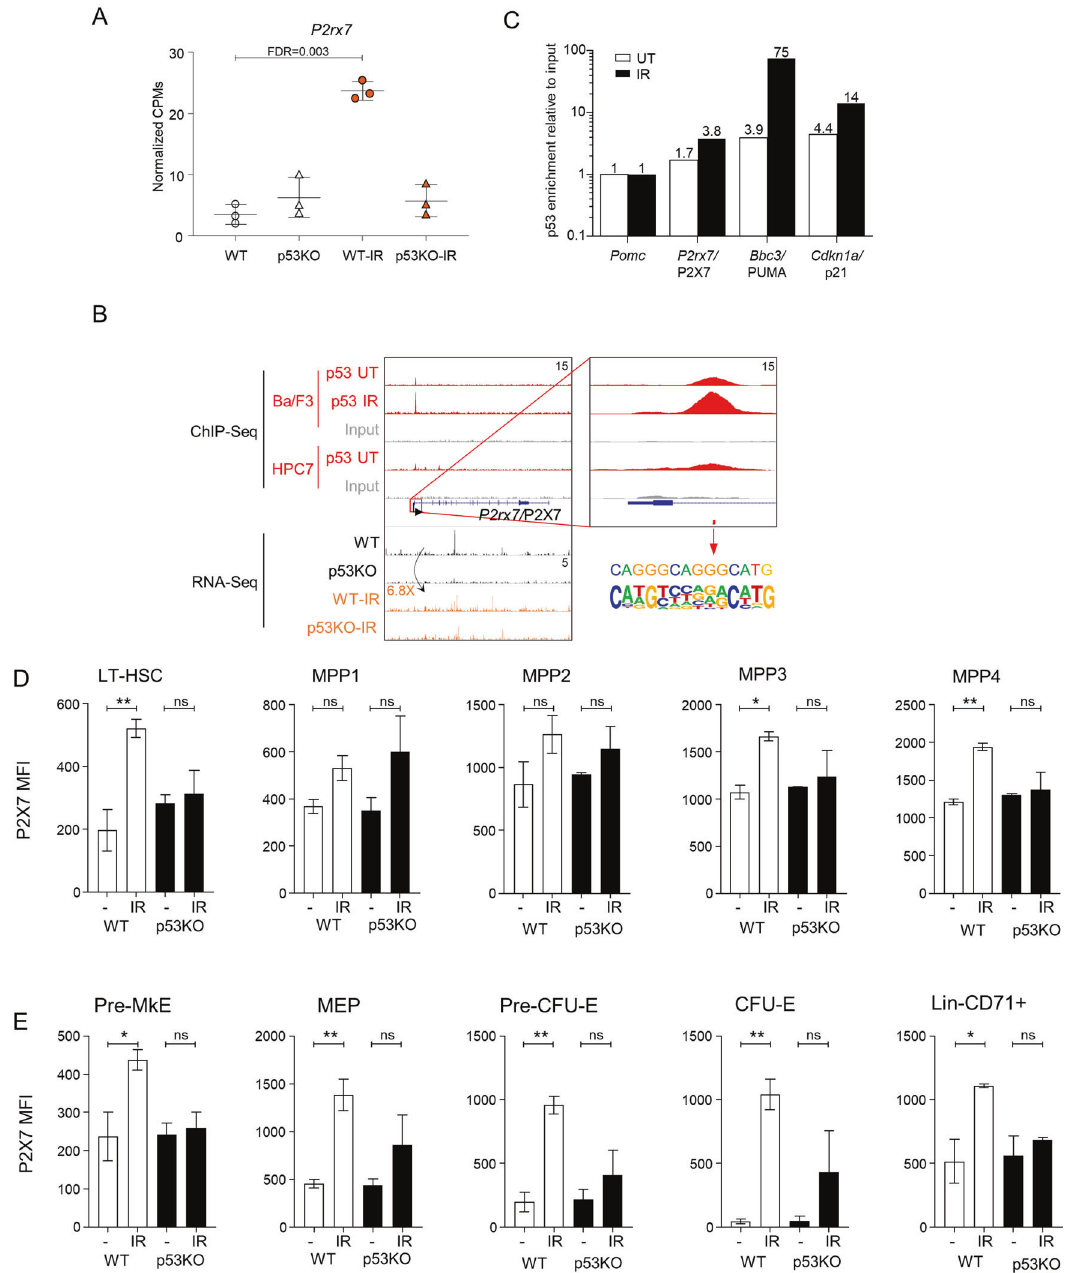
Fig. 5 P2rx7 as a putative novel p53-target gene in HSPC response to irradiation. A Normalized counts per million (CPM) expression of P2rx7 gene in WT and p53KO HSPCs with and without whole-body irradiation. B Genomic snapshots of P2rx7 . ChIP-Seq tracks of p53 in untreated (UT) and irradiated (IR) hematopoietic progenitor cells Ba/F3 and HPC7, and input DNA from the same cells are shown on the top fi ve lanes. The gene feature track is shown in the middle. RNA-Seq tracks of the summation of expression in each group are shown in the bottom four lanes. The maximum data range of each track is indicated at the top-right corner of the track. Red box highlights the p53 consensus binding motif identi fi ed at the promoter of the P2rx7 gene. C Enrichment of p53 at the promoter of P2rx7 gene, validated with ChIP-qPCR in Ba/F3 hematopoietic progenitor cells. p53-regulated genes Bbc3/ PUMA and Cdkn1a/ p21 served as positive controls. Data presented are from one experiment and was reproduced in three independent experiments. D , E P2X7 expression on HSCs and hematopoietic progenitor cells of WT and p53KO mice, with and without whole-body irradiation (3 Gy, 6 h), analyzed by fl ow cytometry; mean fl uorescence intensity of the P2X7 staining is plotted for each cell population. Data are from 3 to 4 mice per genotype per condition, consolidated from 2 to 3 independent experiments; bars represent means and standard errors on the mean (SEM); statistical analysis by ANOVA followed by Sidak ’ s multiple comparison post hoc test to compare WT versus WT-IR and p53KO versus p53KO-IR datasets; * p < 0.05, ** p < 0.01, or ns not signi fi cant. Cells are gated as: D Lin − cKit + Sca1 + followed by CD150 + CD48 − CD34 − Flt3 − for long-term HSCs (LT-HSCs), CD150 + CD48 − CD34 + Flt3 − for MPP1, CD150 + CD48 + CD34 + Flt3 − for MPP2, CD150 − CD48 + CD34 + Flt3 − for MPP3, and CD150 − CD48 + CD34 + Flt3 + for MPP4; E Lin − cKit + Sca1 − followed by CD41 − CD16/32 − CD150 + CD105 − for pre-megakaryocyte erythroid progenitors (pre-MkE), CD34 − CD16/32 − megakaryocyte erythroid progenitors (MEP), CD41 − CD16/32 − CD150 + CD105 + for pre-CFU-E erythroid progenitors, and CD41 − CD16/32 − CD150 − CD105 + for CFU-E erythroid progenitors; or as Lin − CD71 + for the more mature erythroid precursor cells. Cell Death and Disease (2021)